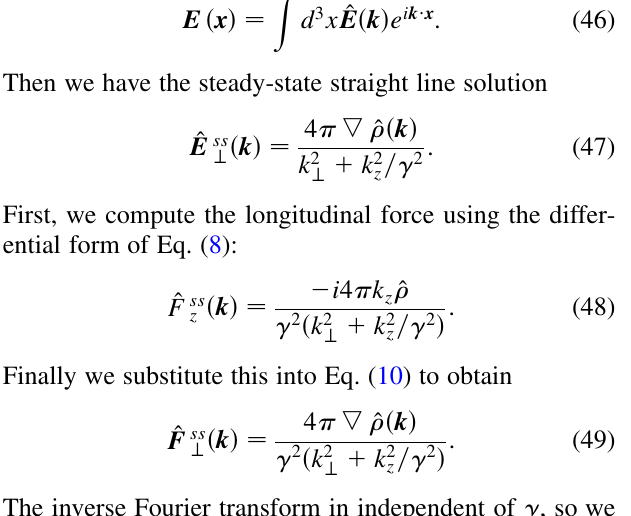
FIG. 3. (Color) Space-charge force x -component as a function of x in a straight 30 (cid:8) 30 cm waveguide, taken at the center point of a three-dimensional Gaussian bunch with rms length (cid:4) 0 : 23 cm , and rms width (cid:4) ? (cid:1) 0 : 2 cm . Simulation results are circles, and theory is represented by a solid line. The force is p (cid:1) Ne 2 = (cid:1)(cid:1)(cid:1)(cid:1)(cid:1)(cid:1)(cid:1) 2 (cid:2) (cid:4) (cid:3) 2 normalized to F z 0